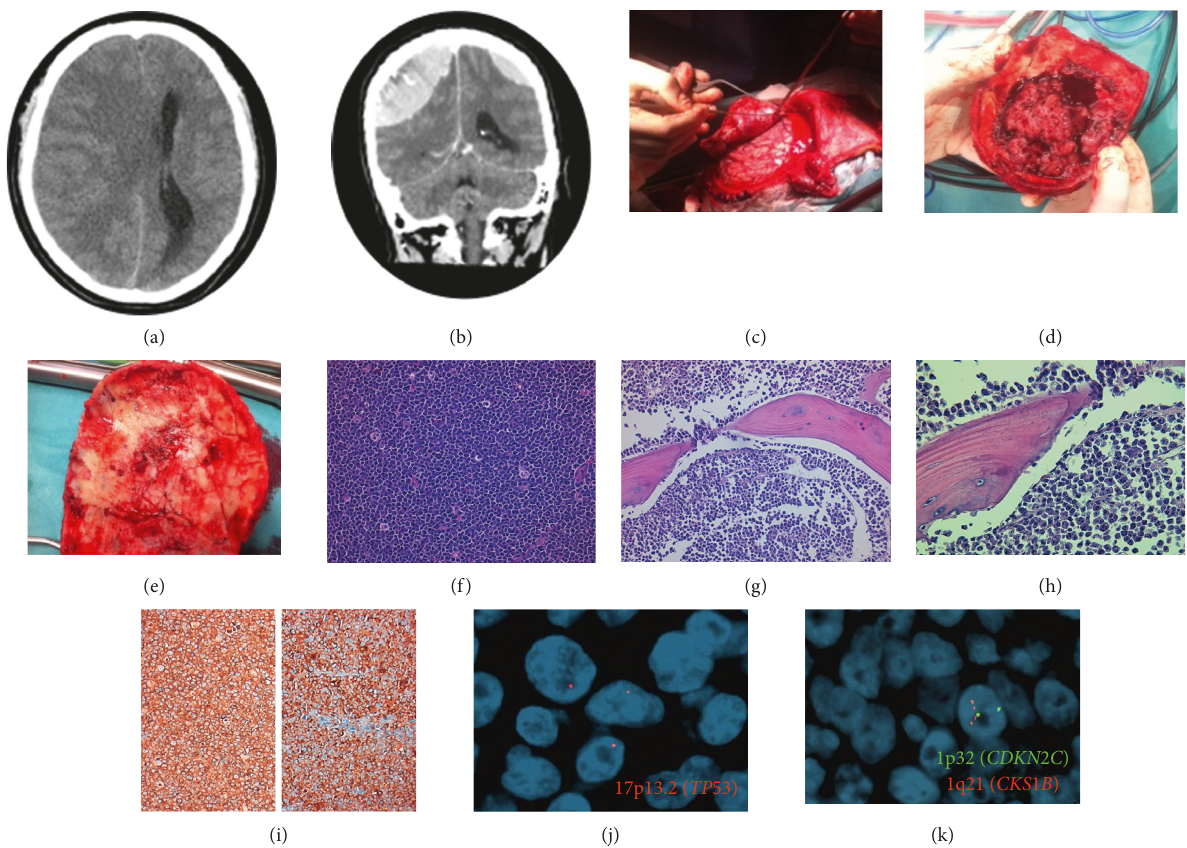
Figure 1: (a, b) Two massive extra-axial tissue lesions (right: 3.5cm in the coronal plane; left: 1.4 cm in the coronal plane), spontaneously hyperdense and with strong contrast enhancement; posterior extension of the lesion with dura infiltration; diffuse involvement calvaria; (c–e) surgical removal of the frontoparietal bone flap with adherent soft tissue lesion and dura mater; (f–i) plasma cells with high mitotic activity and apoptotic bodies. (HE, 200x); invasion of the bone. (HE, 400x); (j, k) 1p32/1q21 and 17p13.2 (TP53) copy number changes evaluated by FISH: (j) (17p13.2, red), (k) (1p32, green and 1q21, red), (j) del17p13.2 (30%), and (k) 1q21 gain